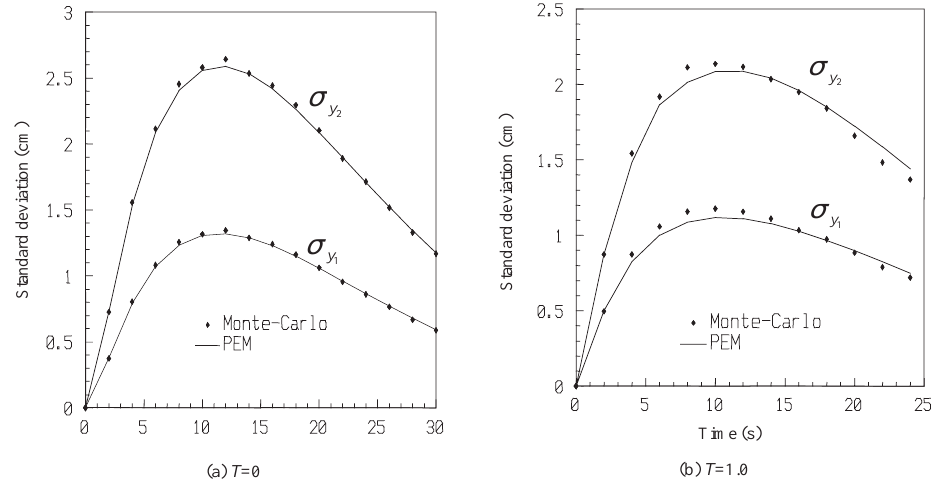
Fig. 2. Displacement standard deviation comparison using PEM and Monte-Carlo